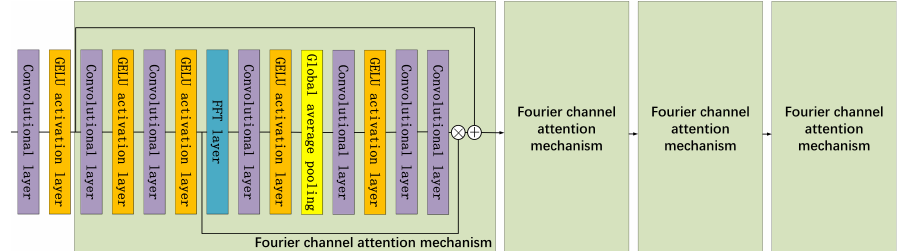
Figure 1. The structure of FAB. The Fourier attention module is composed of four Fourier channel attention mechanism blocks. The Fourier channel attention mechanism (solid green box) consists of a fast Fourier transform (FFT) layer, a global average pooling layer, convolution layers, and Gaussian error linear unit (GELU) activation layers. ⊕ and ⊗ represent the matrix addition and multiplication, respectively. The black arrows represent the flow of the data.